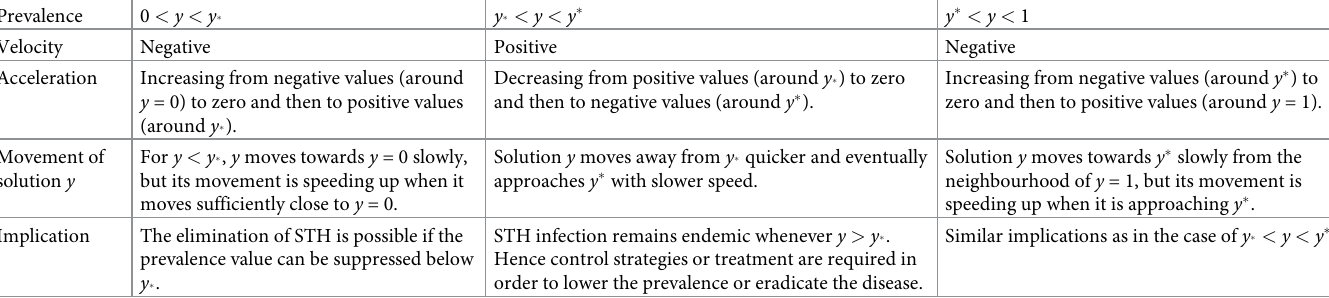
Table 2. The movement of y and its